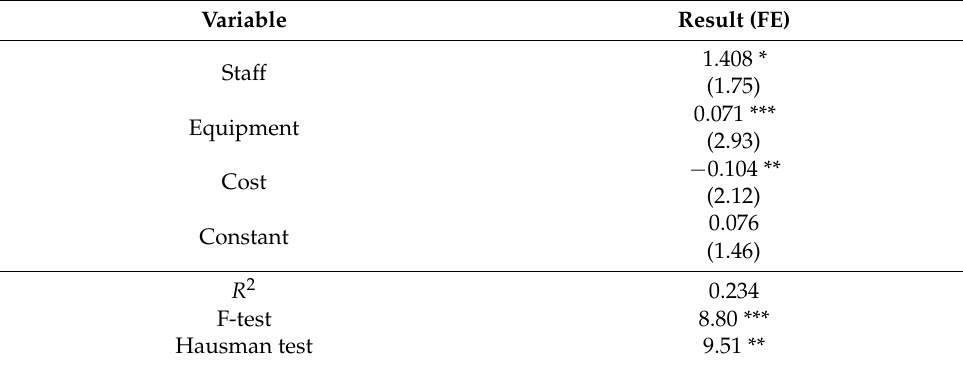
Table 9. Impact of input variables on innovation